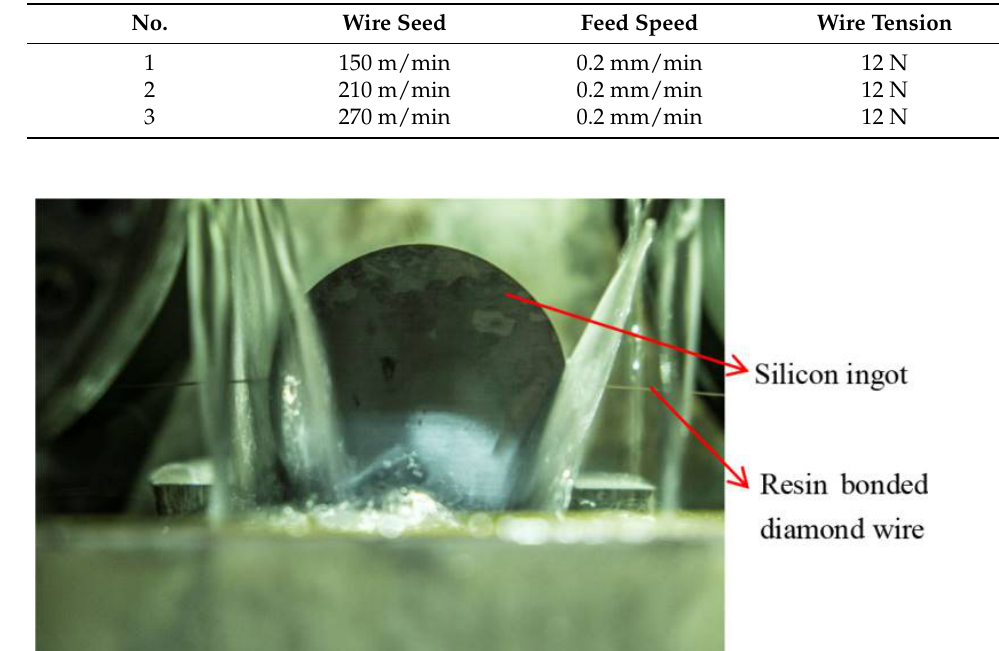
Figure 3. The process of resin bonded diamond wire sawing silicon ingot. Table 1. The processing parameters of wire sawing experiment.